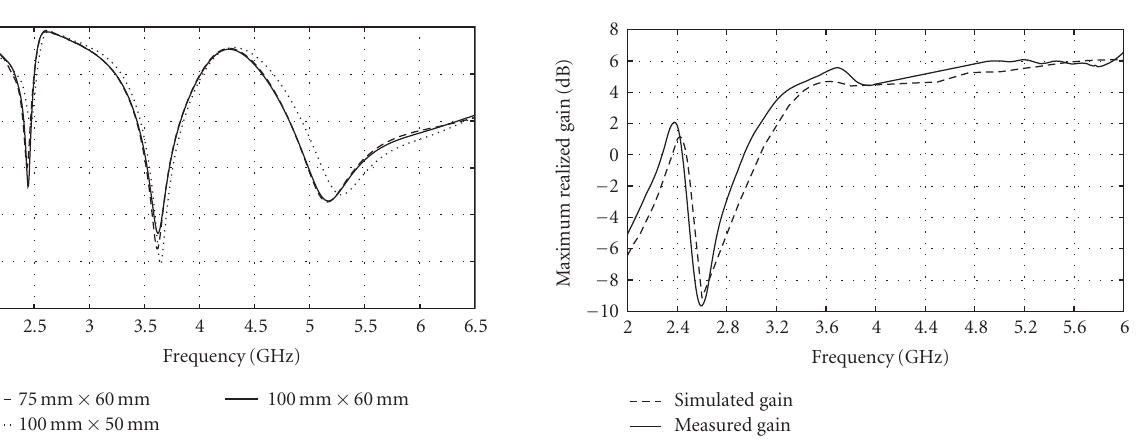
Figure 8: Simulated and measured maximum gain of the tri-band